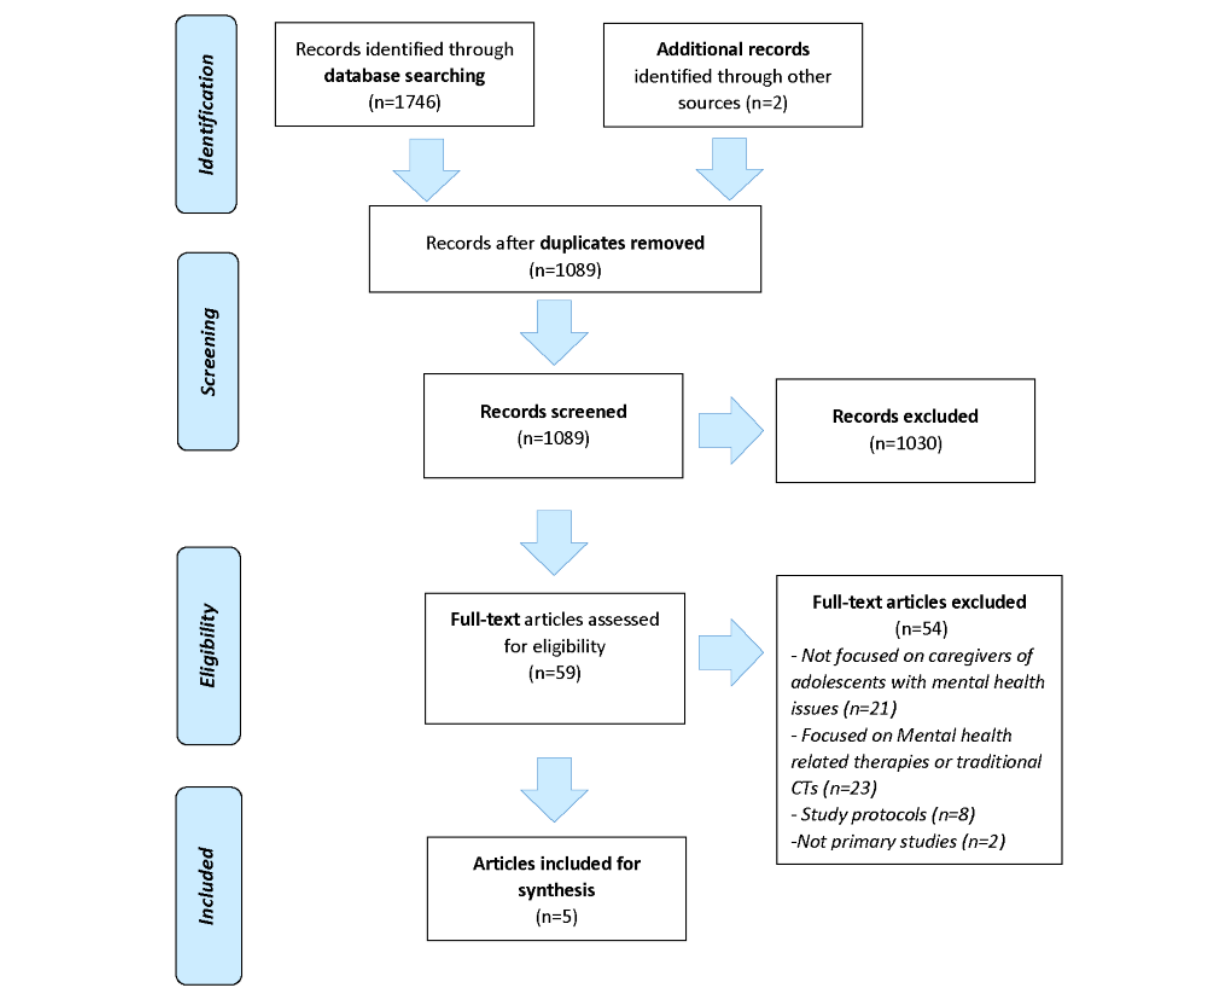
Figure 1. PRISMA flow